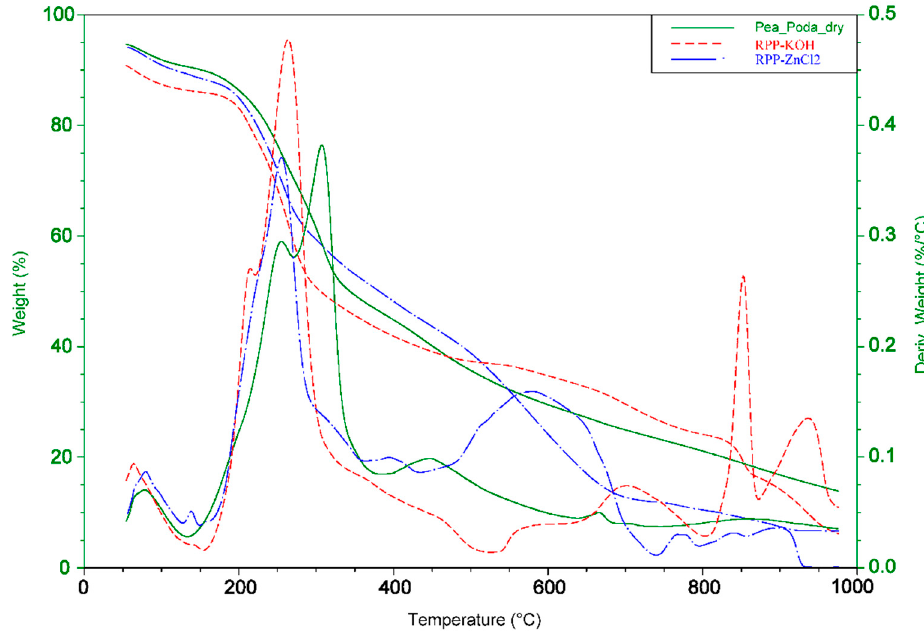
Figure 5. TGA and DTA of raw pea pods (green), pea pods + KOH (red), and pea pods + ZnCl 2 (blue) under temperatures from 50 to 1000 °C.